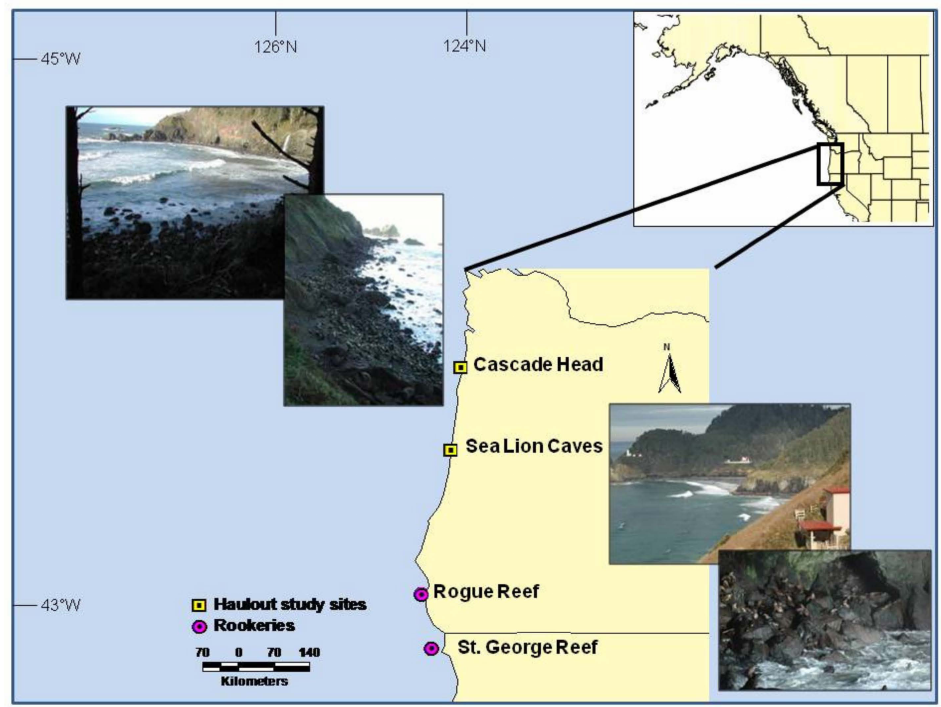
Figure 1. Map depicting Oregon haul-outs where Steller sea lions were observed during 2005–2009. Rookeries indicate where Steller sea lions were branded as